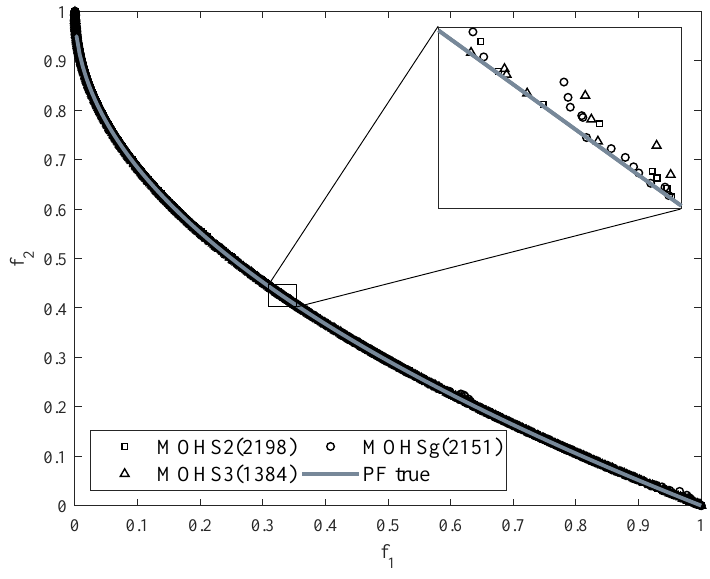
Figure 2. Pareto fronts for problem P1.